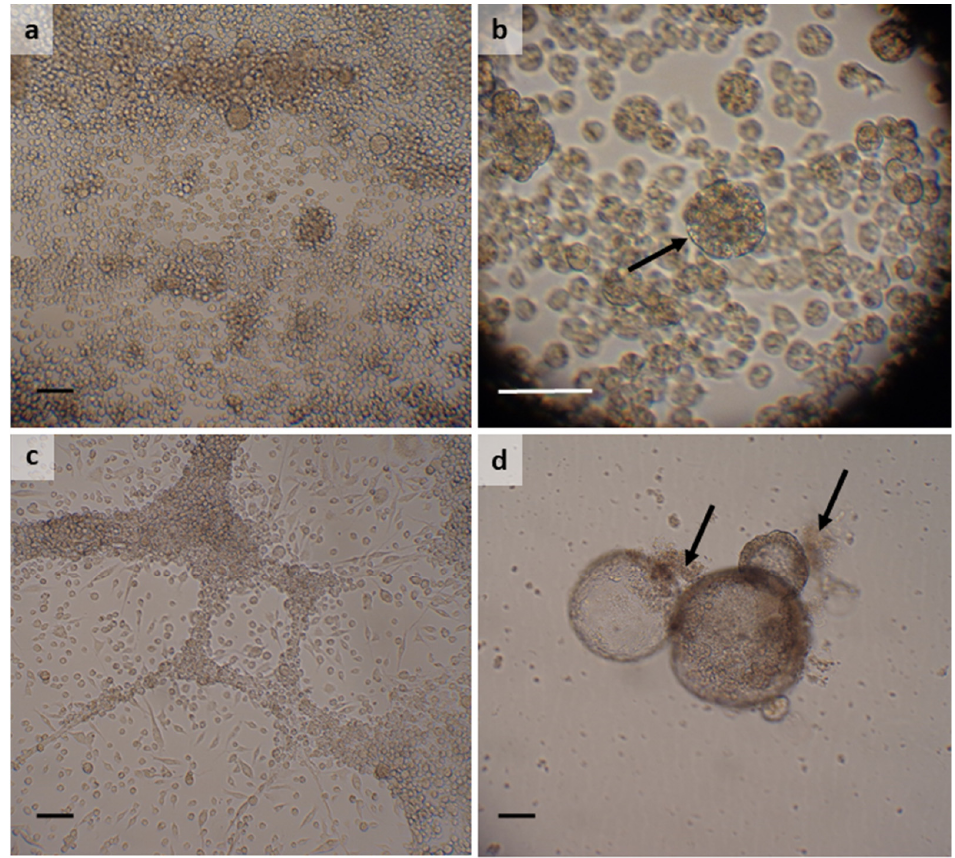
Figure 2 . Hyalomma lusitanicum and Hyalomma scupense cell lines. ( a ) H. lusitanicum cell line HLE/LULS42 at passage 2, 8 years after initiation; ( b ) H. lusitanicum cell line HLE/LULS48 at passage 6, 8 years after initiation, showing a cell cluster bounded by a membrane (arrow); ( c ) H. scupense cell line HSE/LULS51 at passage 9, 6 years after initiation; ( d ) H. scupense cell line HSE/LULS59 at passage 9, 6 years after initiation, showing extracellular matrix associated with the multicellular vesicles (arrows). Live, inverted microscope, scale bars = 100 µm.